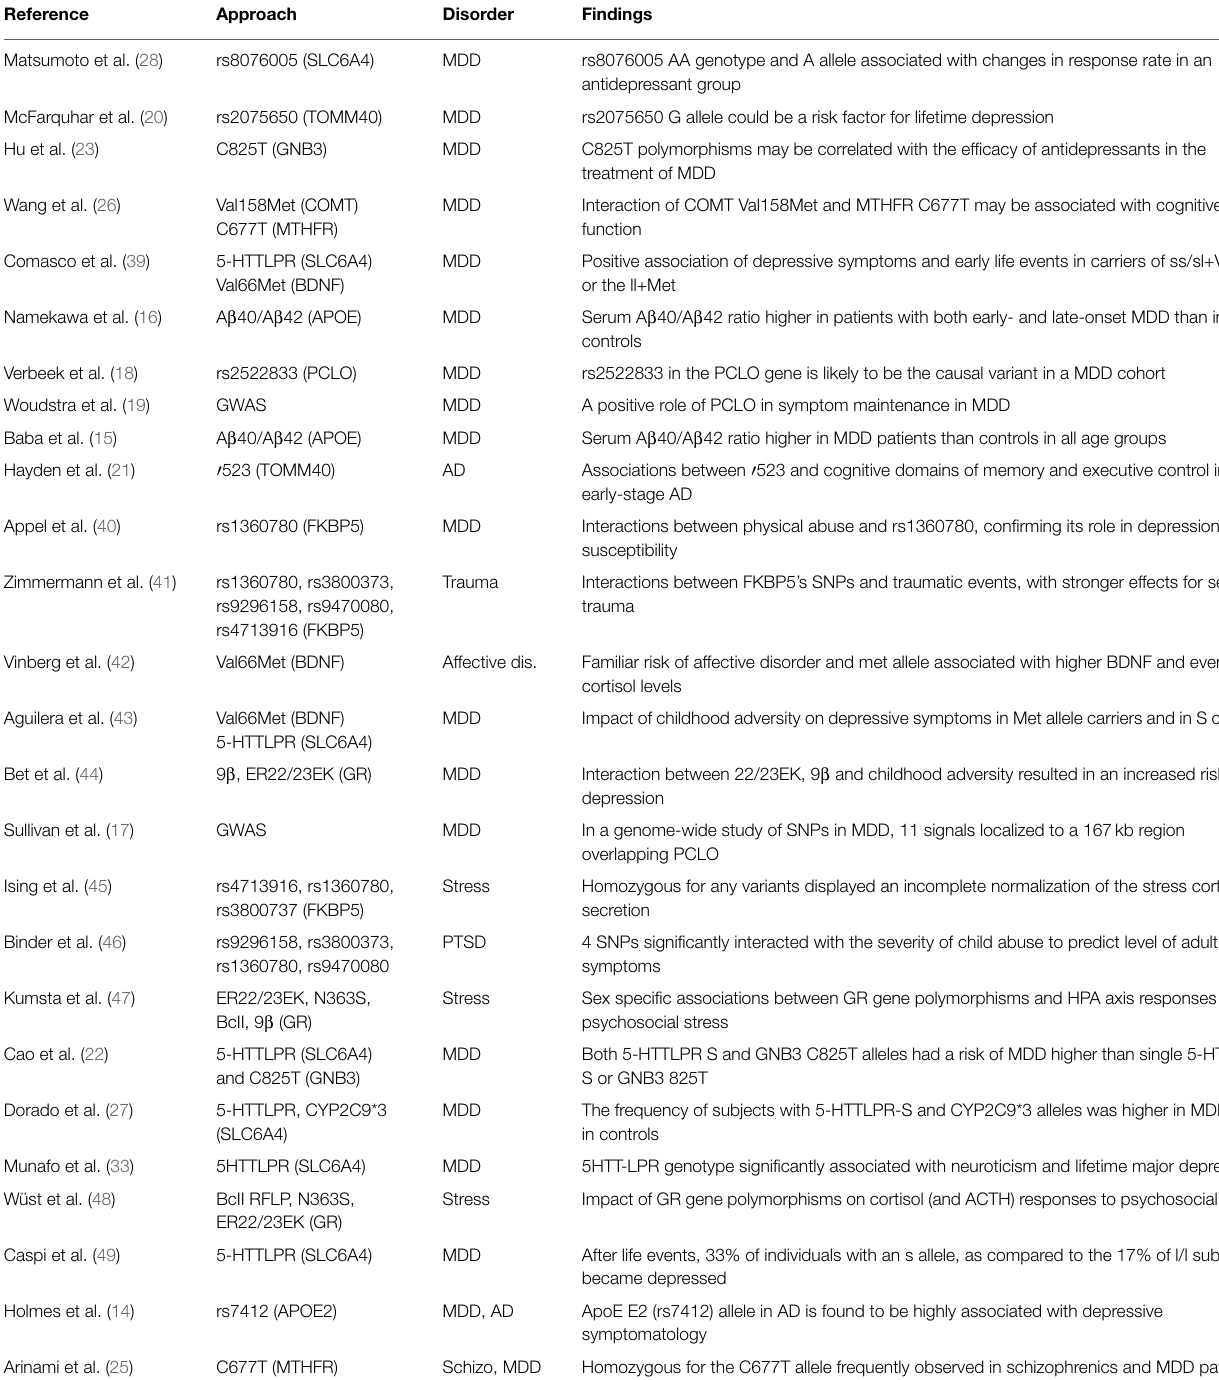
TABLE 1 | Genetic approach for gene–environment interaction